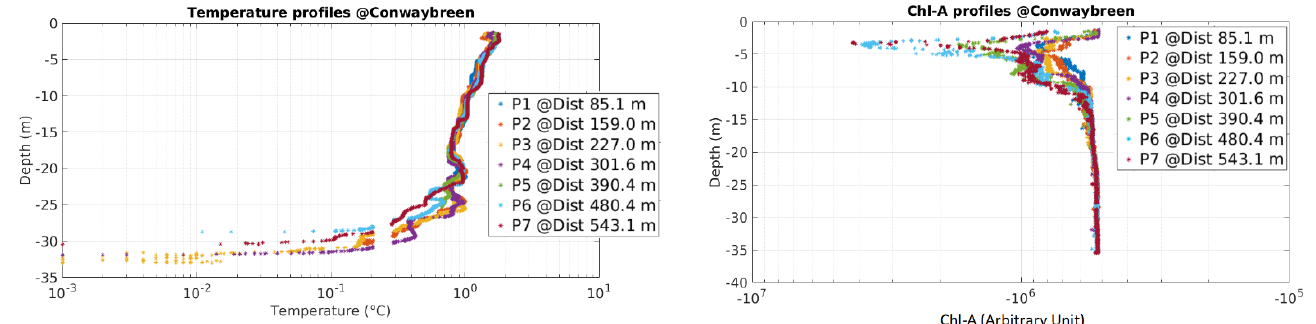
Figure 10. Semilogarithmic scale graphs of temperature and chlorophyll-a of the vertical